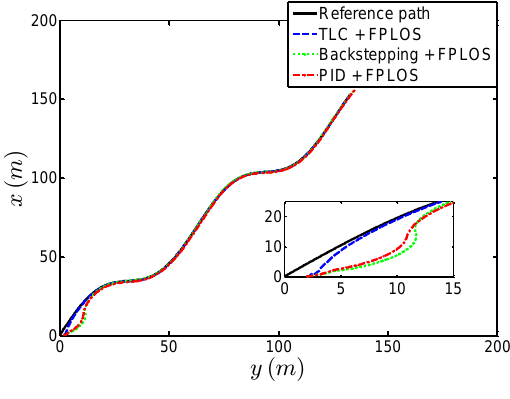
Figure 11. Path following performance.